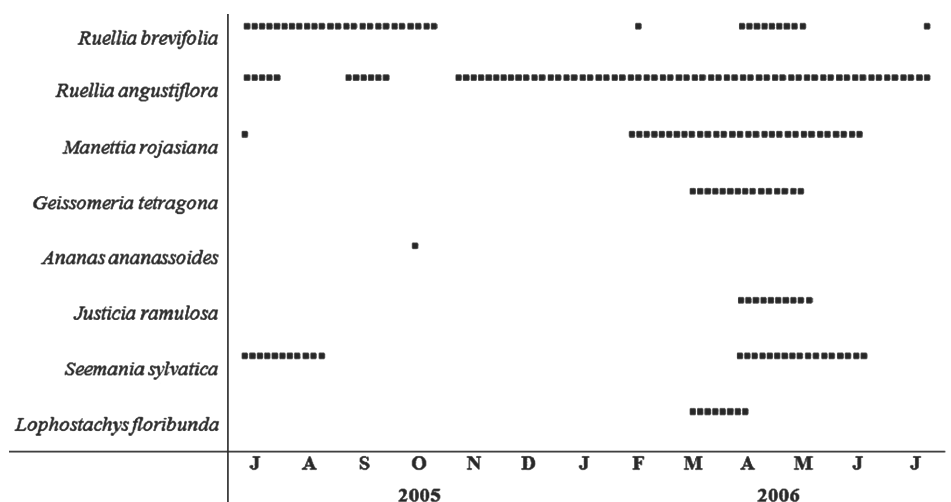
Fig. 3 – Flower density in riparian and semi-deciduous forests at Serra da Bodoquena from June 2005 to July 2006.